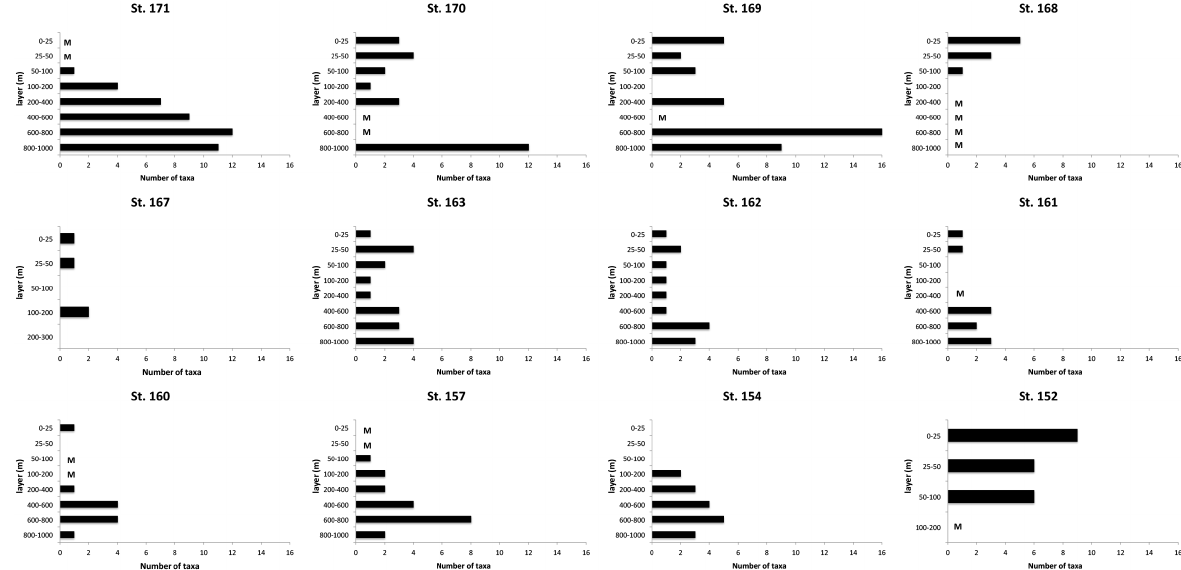
Figure 5. MOCNESS data set. Number of jellyfish taxa found at different depths in the 0–1000m layer. Please note the shallower depths in stations 152 and 167. Station 155 is not shown. M: samples preserved in formalin, not yet analysed.